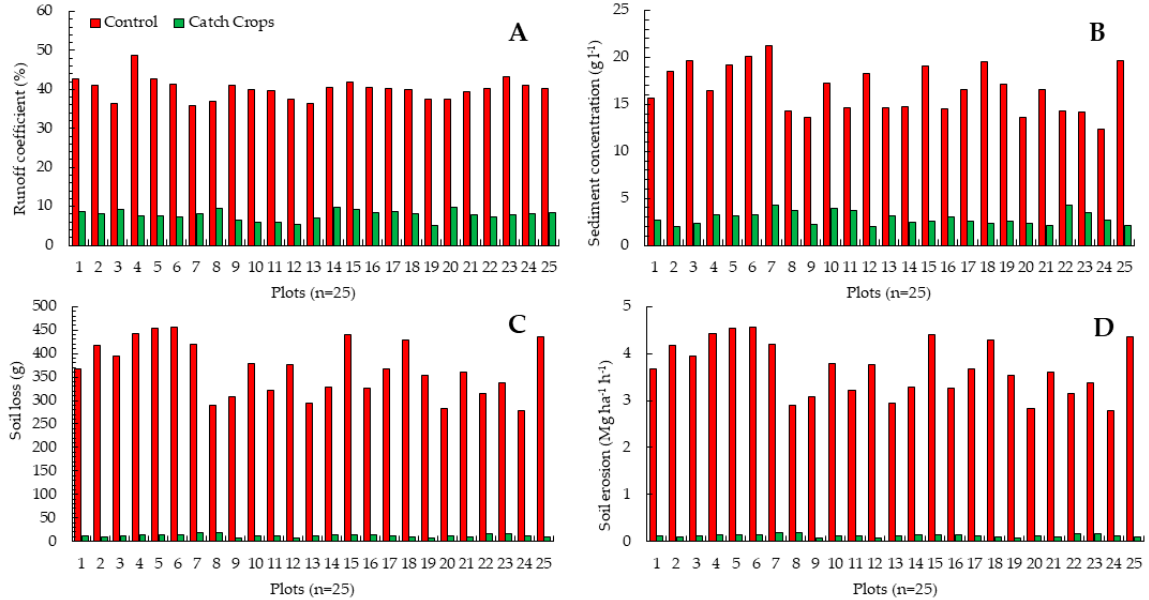
Figure 6. Soil erosion results obtained in the control and catch crops plots. ( A ) runoff coefficient; ( B ) sediment concentration; ( C ) soil loss; and, ( D ) soil erosion.